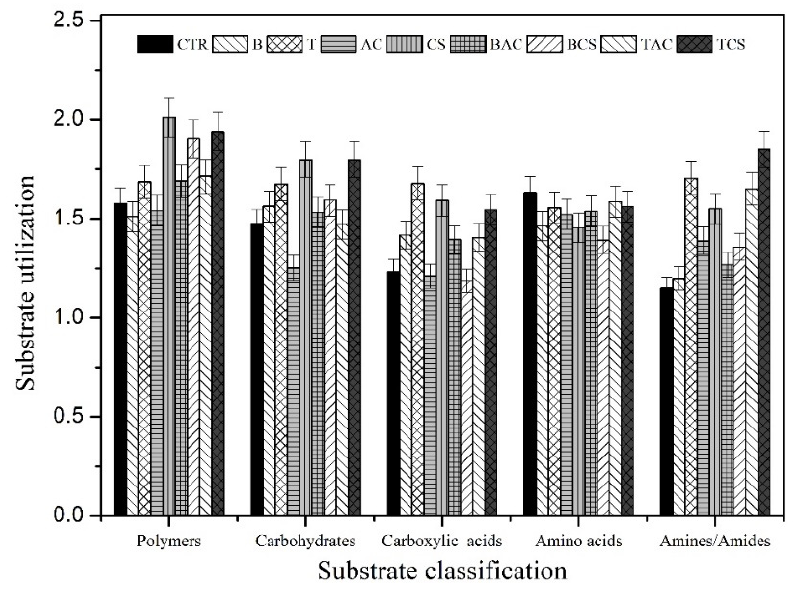
Figure 8. Carbon substrate classification of various amendment treatments after 120 h incubation (CTR: control, B: bentonite, AC: activated carbon, CS: cornstarch). Data are mean ± standard deviation (n = 3).